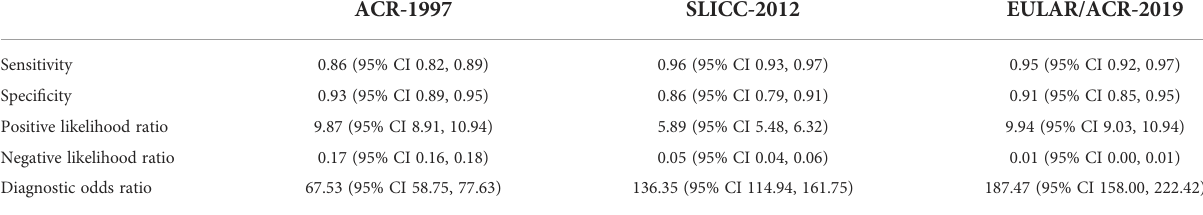
TABLE 1 Results from